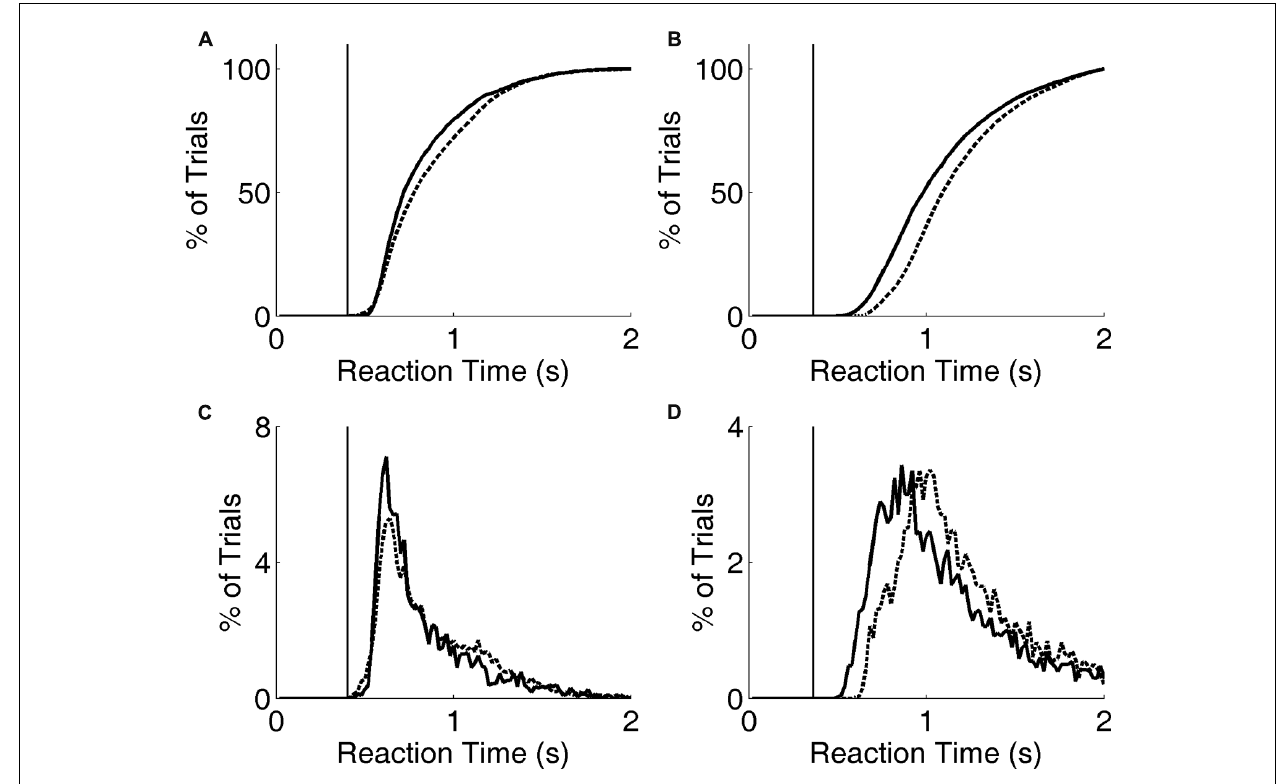
of reaction times for a different rat performing a more difficult image discrimination (gray lines in Figure 5 ). Median reaction time increased from 0.993 to 1.102 s. The rat’s lifetime minimum reaction time is indicated by the thin vertical line. (C) Raw reaction time distributions corresponding to data of panel (A) . (D) Raw reaction time distributions corresponding to data of panel (B)